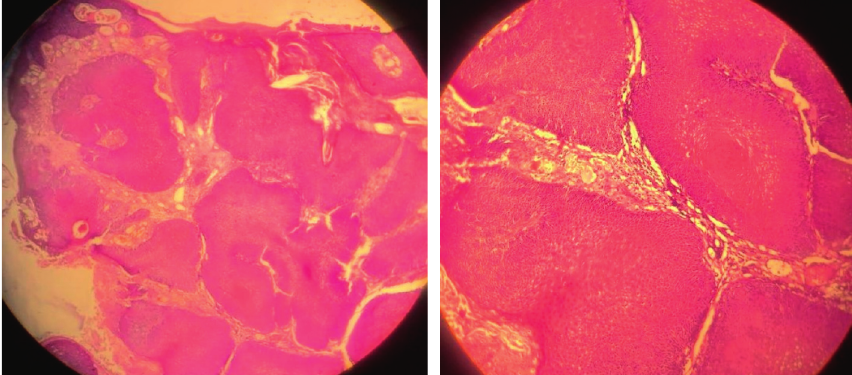
Figure 2: Pathological examination showing a very well-differentiated squamous cell tumor proliferation with an exophytic and endophytic tumor architecture bordered by hyperkeratosis and parakeratosic